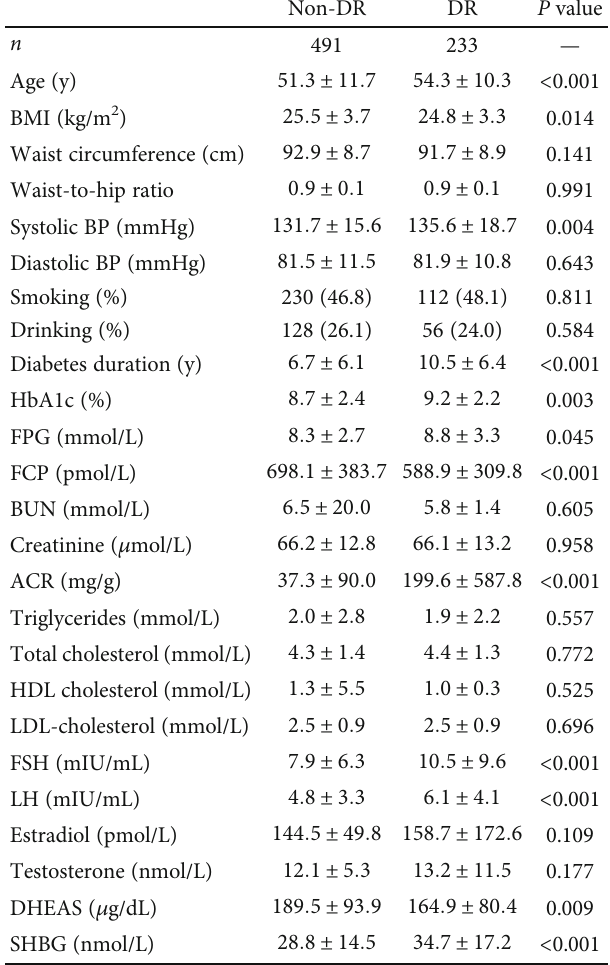
Table 3: Characteristics of male subjects with or without diabetic retinopathy.